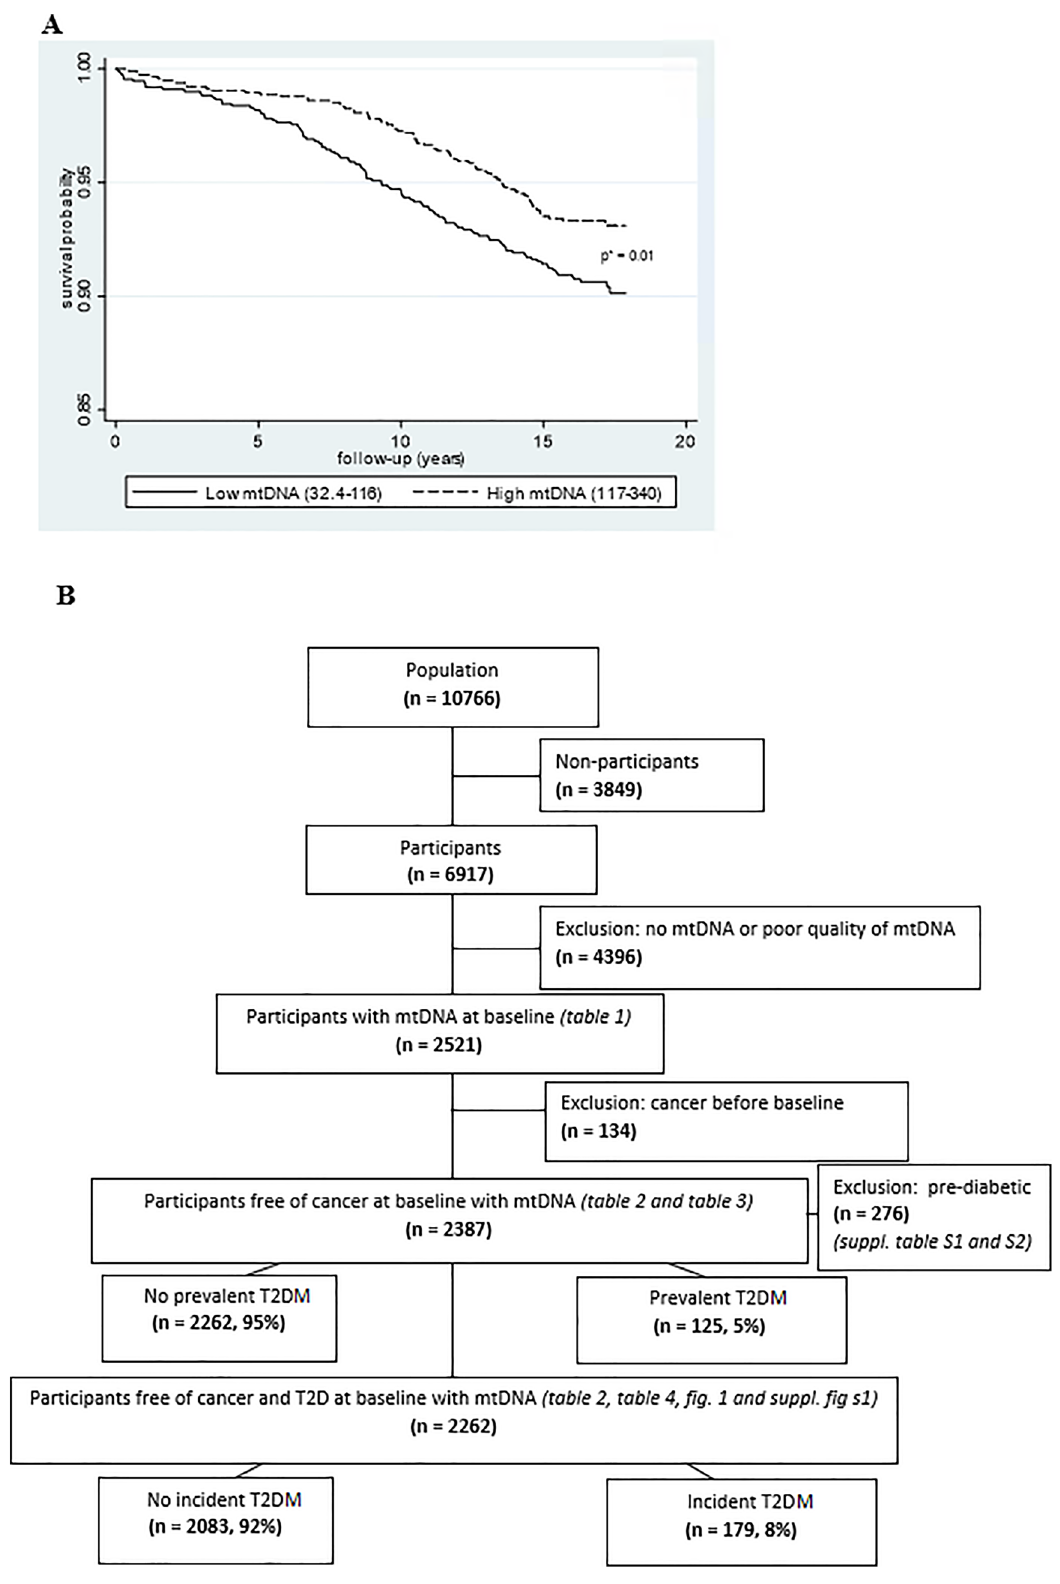
Figure 1. ( A ) Kaplan–Meier curves were plotted to calculate the probability of population free of T2DM during follow-up. Mitochondrial DNA-CN was dichotomized into high (dotted line) and low (continuous line) according to the median. * p value for difference in time to T2DM between low and high mtDNA (log-rank test). ( B ) Flowchart for population included in the